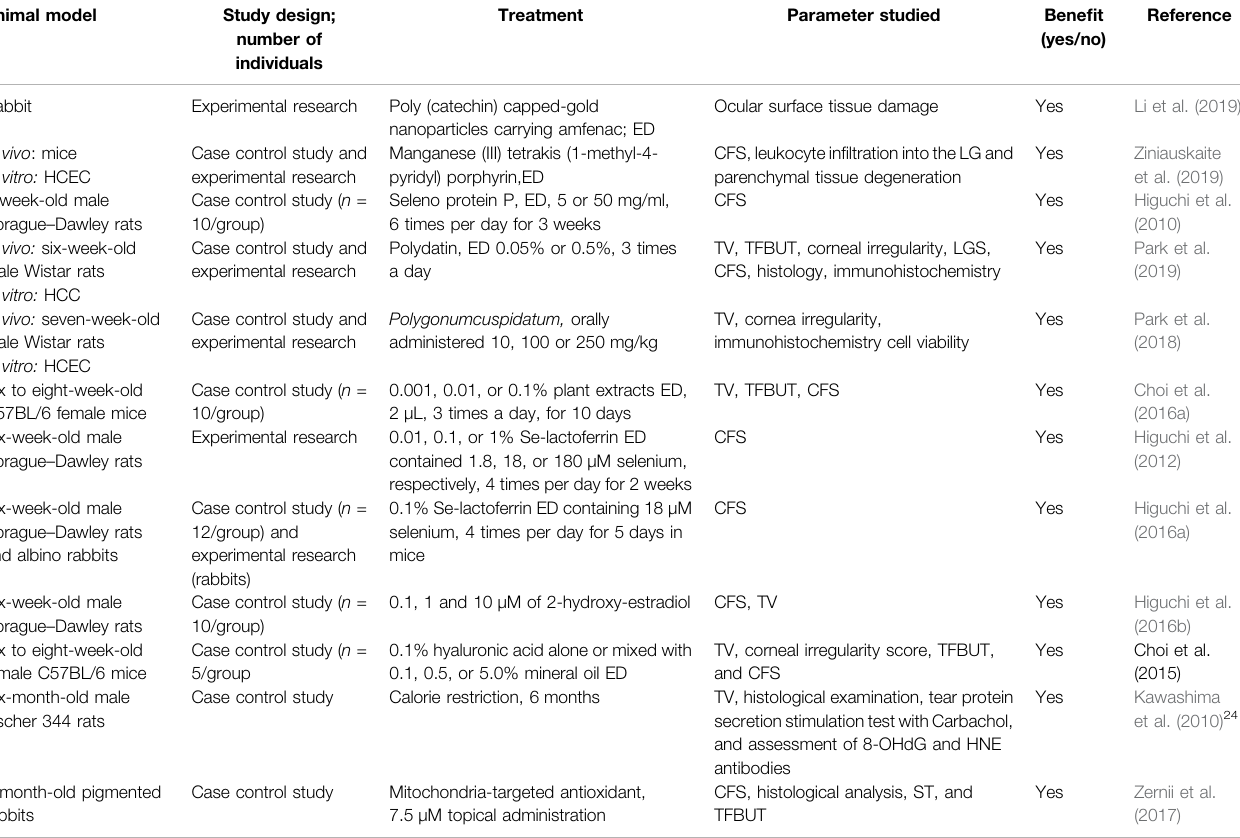
TABLE 4 | Preventive and therapeutic antioxidant strategies for DE disease in animal models published between 2010 and 2019 were searched for “ antioxidant ” and “ dry eye ” in PubMed. Animal